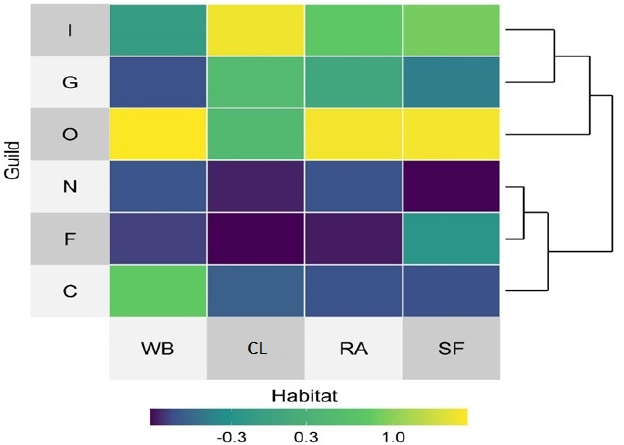
Figure 9. Heat map showing the distribution pattern of various feeding guilds in different habitats; blue